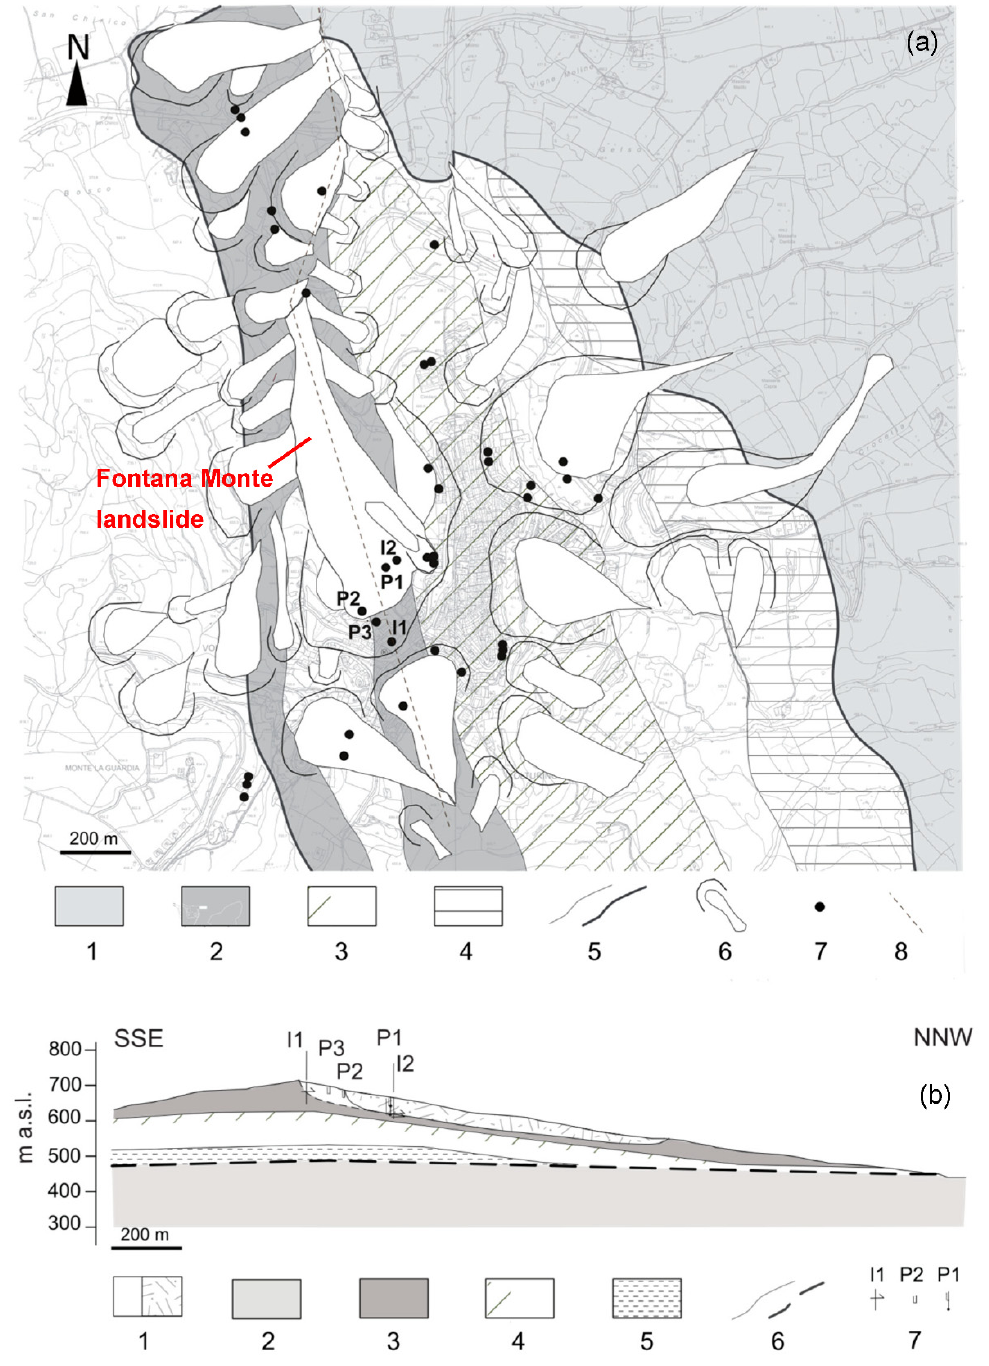
Figure 7. Volturino: ( a ) geological/geomorphological map; ( b ) longitudinal cross-section of Fontana Monte landslide (after [23,49]; modified). Key of ( a ): (1) Sub-Apennine clays; (2) Toppo Capuana clays and marls; (3) Faeto Flysch (diagonal lines indicate rocky portion); (4) Red Flysch; (5) stratigraphic (left) and tectonic (right) contact; (6) landslide body and crown; (7) boreholes; (8) trace of longitudinal cross section. Key of ( b ): (1) landslide body (solid white for retrogression area); (2) Sub-Apennine clays; (3) Toppo Capuana clays; (4) Faeto Flysch (diagonal lines indicate rocky portion); (5) Red Flysch; (6) stratigraphic (left) and tectonic (right) contact; (7) field investigations: inclinometer (left), standpipe (middle), Casagrande piezometer (right).